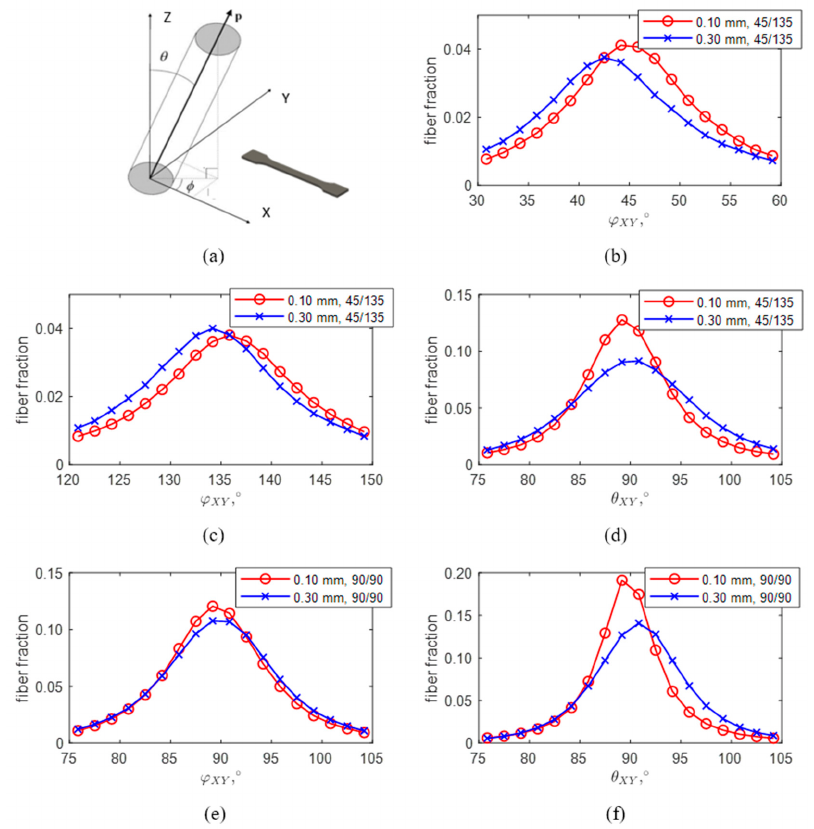
Figure 3. ( a ) Polar coordinate system, where the orientation of fibers are described by two angles: in-plane ϕ -angle and out-of-plane θ -angle. Fiber orientation distributions obtained for the specimens with a raster angle of (45, 135) and thicknesses of 0.10 mm (red) and 0.30 mm (blue), ( b ) 45° in-plane orientation, ( c ) 135° in-plane orientation, and ( d ) out-of-plane orientation. Fiber orientation distributions obtained for the specimens with a raster angle of (90, 90) and thicknesses of 0.10 mm (red) and 0.30 mm (blue), ( e ) in-plane orientation and ( f ) out-of-plane orientation. The in-plane angle— φ XY (Figure 3b,c,e) corresponds to the printing direction of the printhead nozzle and mainly lies in the range of ±10° for both the raster configurations of (45, 135) and (90, 90) for a given range of printed layer thicknesses from 0.10 to 0.30 mm. At the same time, the out-of- plane fiber orientation distribution ( θ -angle) is not as emphasized for the thicker 0.30 mm layers, when compared to the thinnest 0.10 mm layers, for both raster configurations (Figure 3d). Therefore, we can conclude that the fibers are mostly aligned with the nozzle movement direction, regardless of printing layer thickness. This happens when fibers are extruded along with the polymer matrix and are confined between the previous printed layer and the printing nozzle. For the thinner layers a notably higher degree of fiber orientation and more uniform distribution in the out-of-plane ( θ -angle) direction can be observed. This is confirmed by the micro-CT analysis (Figure 4a,b).